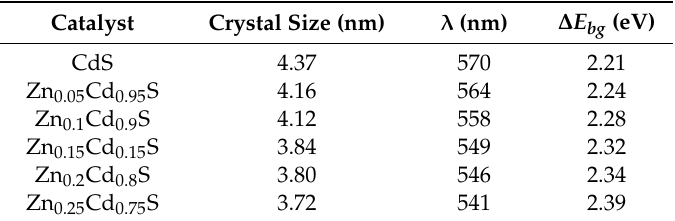
Table 1. Crystallite size (from XRD), wavelength ( λ ) and energy band gap estimation ( Δ E bg ) of pure CdS and Zn x Cd 1 − x S solid solutions.